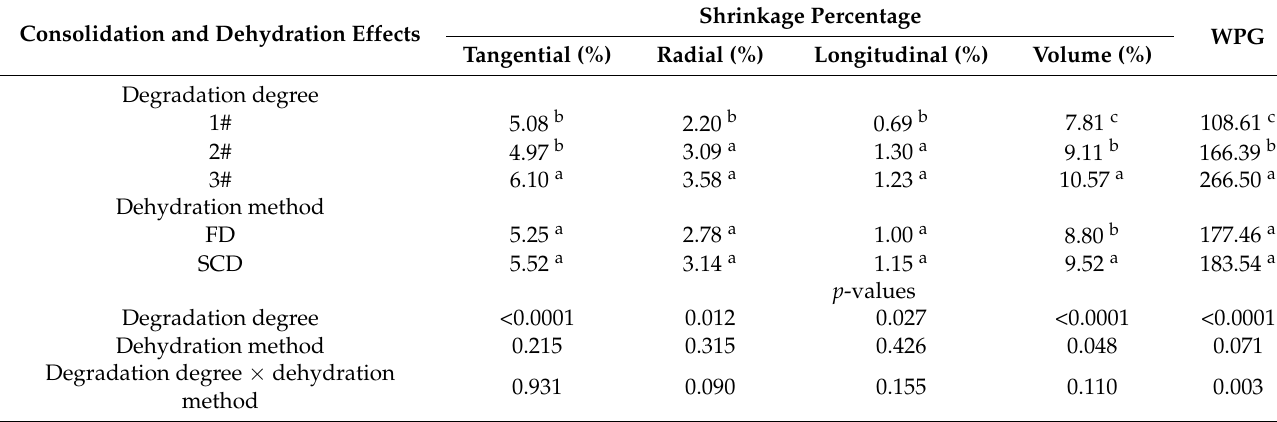
Table 2. Consolidation and dehydration effects on shrinkage percentage and WPG.